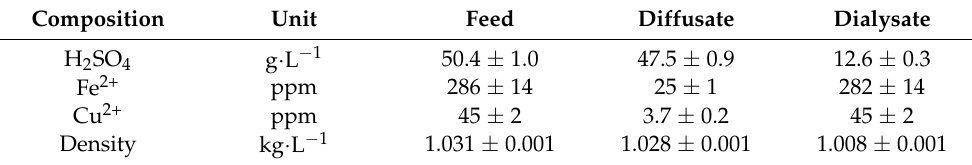
Table 6. Analytical measurements for Test